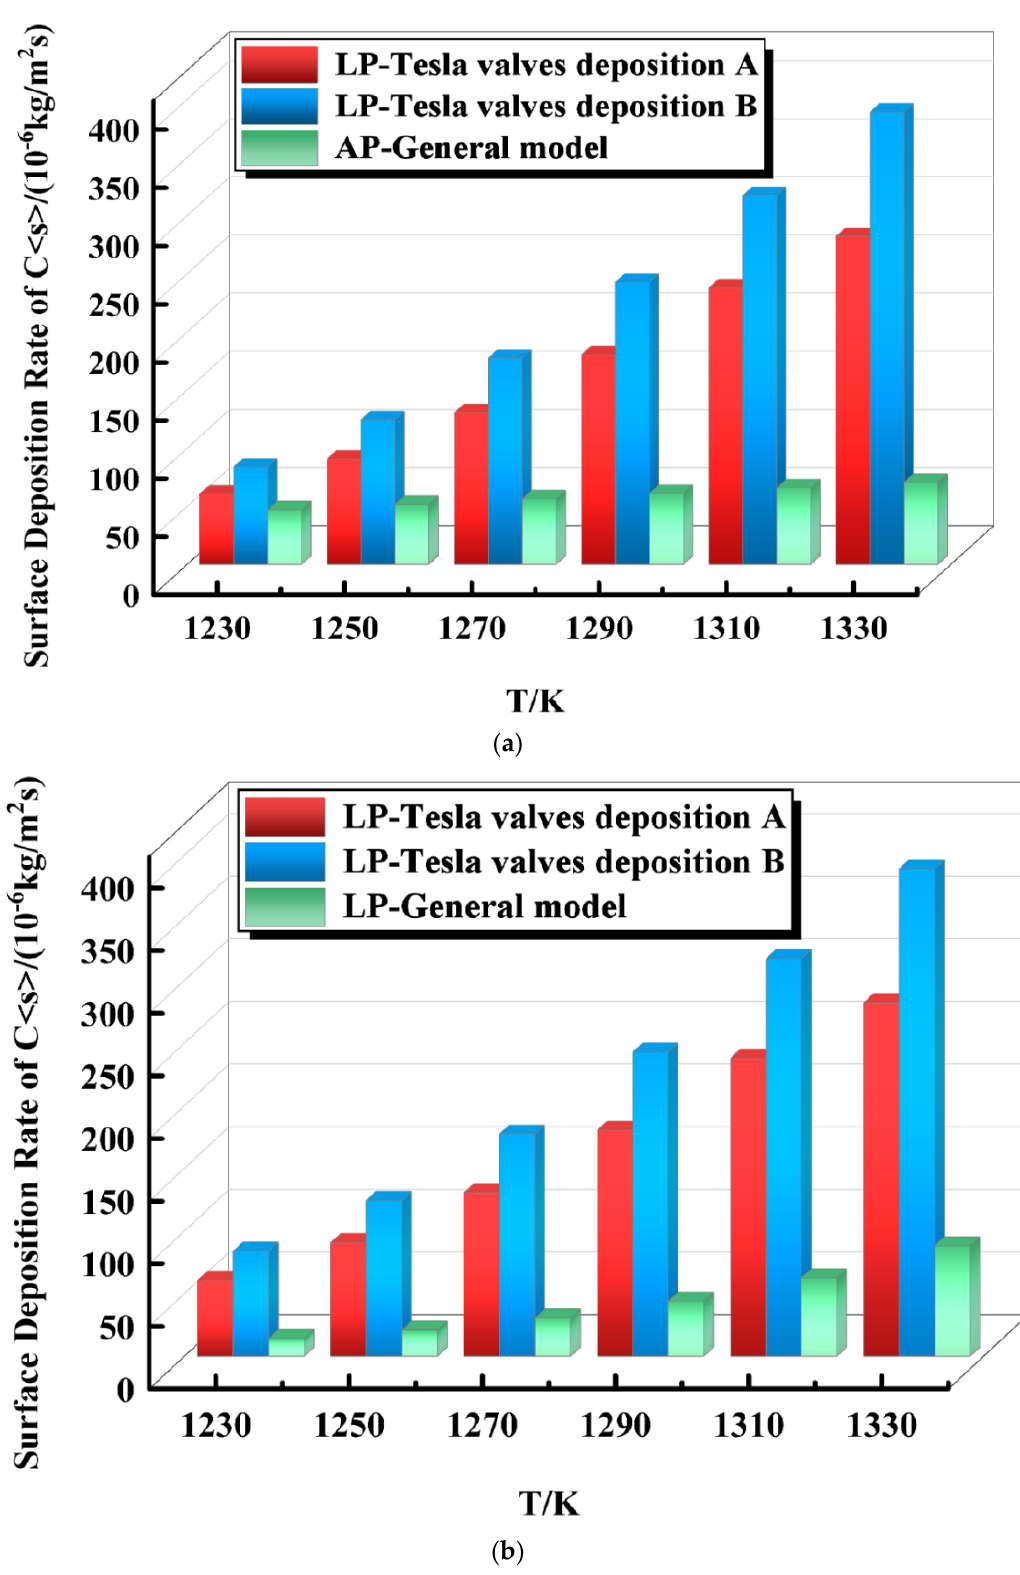
Figure 12. Atmospheric and low surface deposition rate of c
with different temperature in reverse flow: ( a ) deposition A; ( b ) deposition B.